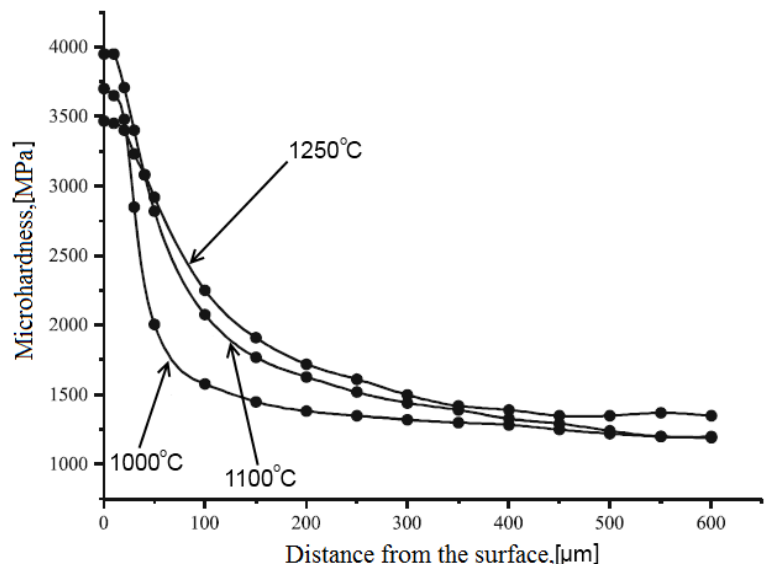
Figure 8. Microhardness profiles for Fe-FeTi samples sintered at different temperatures in the ammonia